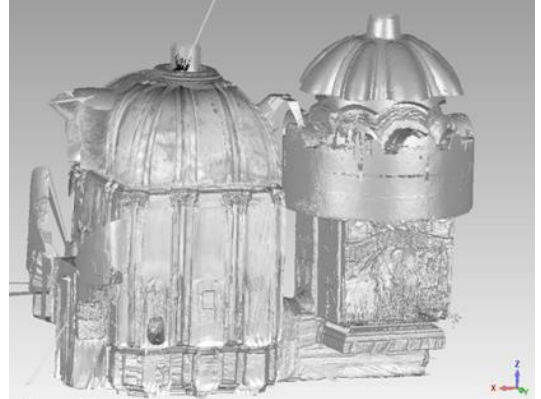
Figure 7: Part of the registered point clouds inside the Holy Aedicule